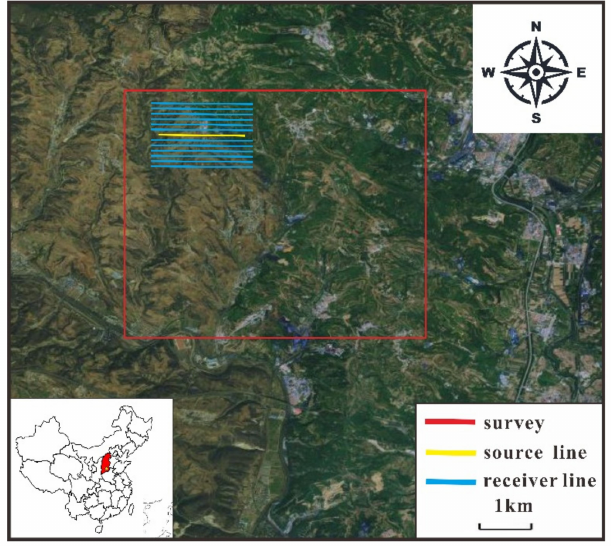
Figure 12. Map of the survey